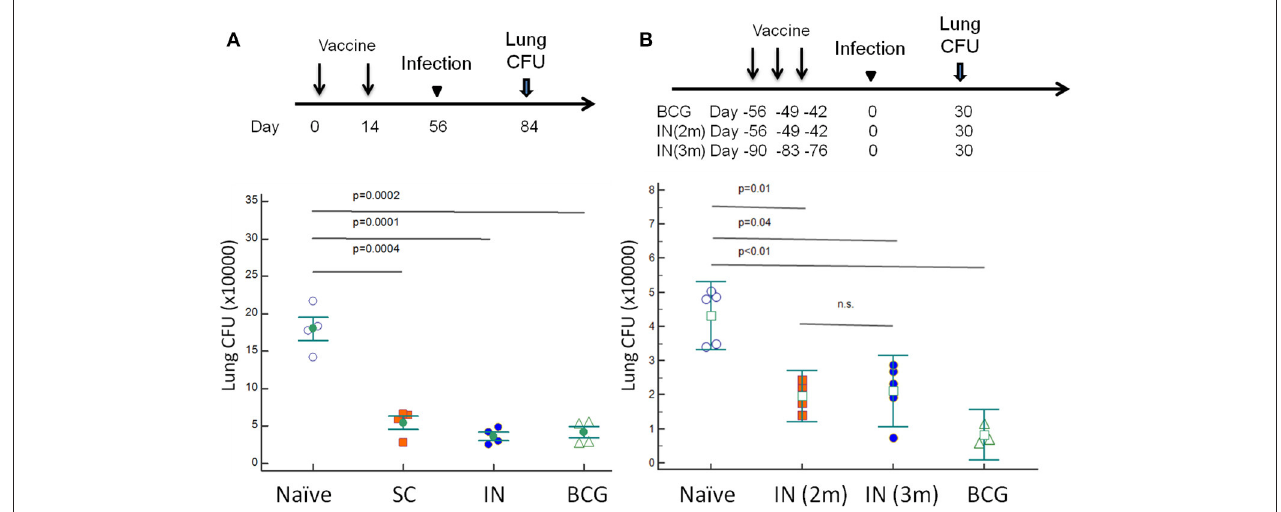
FIGURE 5 | Vaccination with DnaK protein confers equivalent protective immunity as BCG vaccination. (A) C57BL/6J mice were vaccinated twice with DnaK (100 µ g) by subcutaneous injection or DnaK (20 µ g) by intranasal injection. Control mice were subcutaneously vaccinated with BCG Pasteur once. Eight weeks after vaccination, all mice were aerosol-challenged with virulent M. tuberculosis H37Rv. Four weeks after infection, the lung bacillary burden (log 10 CFU) was determined. Mean ± SEM, * p < 0.05 (B) . To confirm the protection of intranasal vaccination, C57BL/6J mice were vaccinated with DnaK (20 µ g) intranasally once a week for a total of 3 weeks, at two (IN 2m) or 3 months (IN 3m) before H37Rv aerosal infection in another experiment. The vaccinated and unvaccinated group of mice were infected at the same time. Lung bacillary burden (log 10 CFU) was determined 30 days after aerosol challenge. Mean ± SEM, * p <